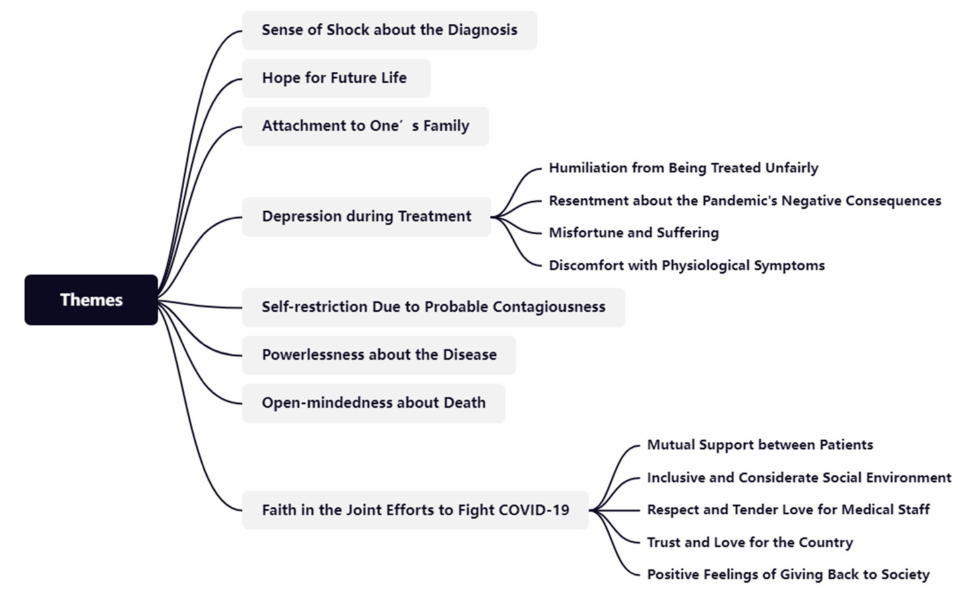
Figure 2. Themes and subthemes of COVID-19 patients’ emotional